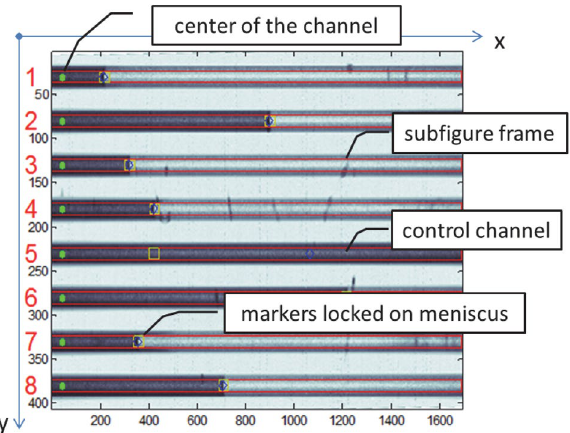
Figure 4. Labeled microchannels and automatically determined centers of the channels (green dots).